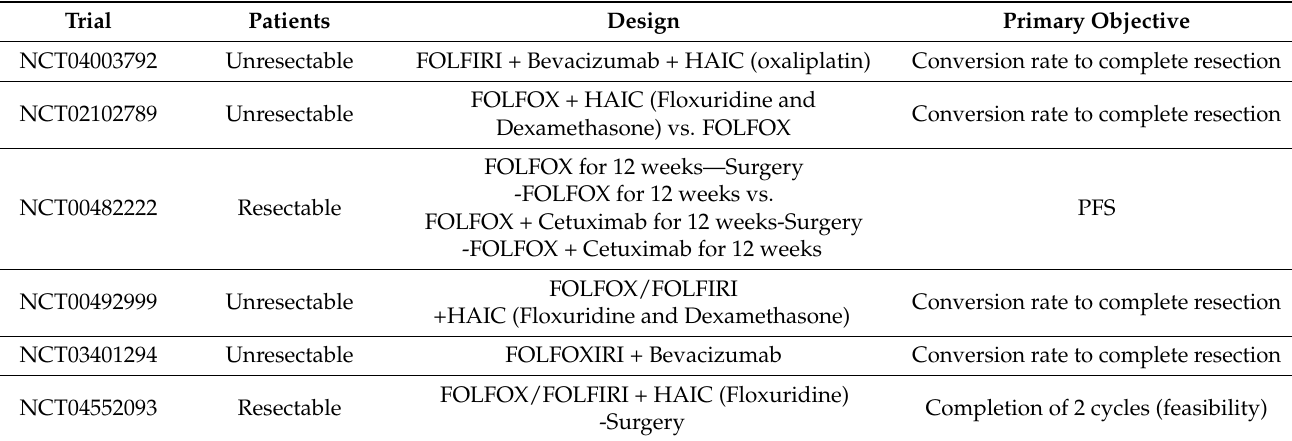
Table 4. Ongoing clinical trials of perioperative systemic treatment for colorectal liver metastases.